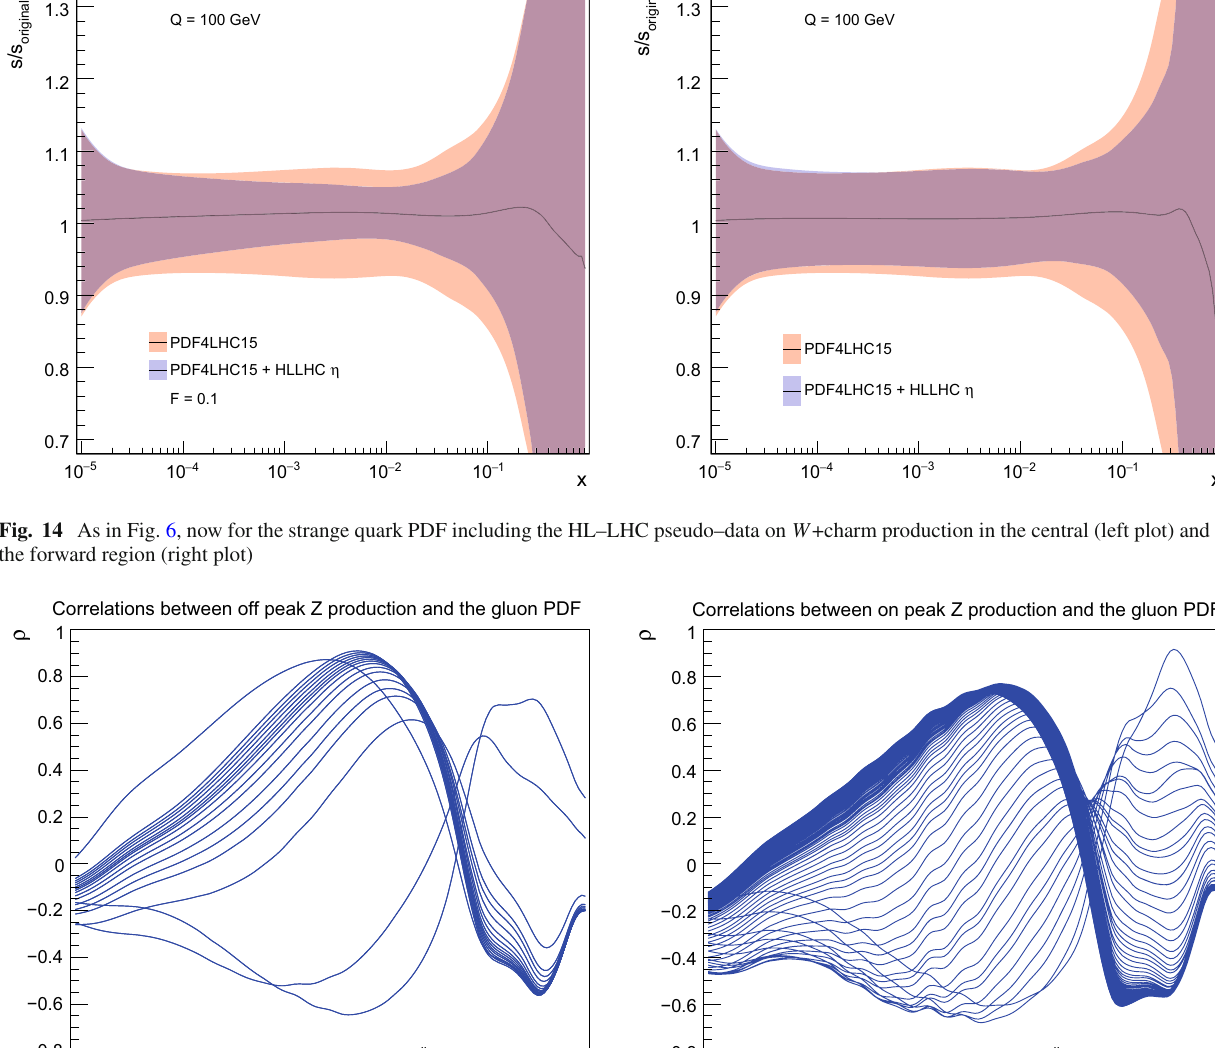
show the data vs. theory comparison only for the dominant dilepton invariant mass bin, 66 GeV ≤ m ll ≤ 116 GeV, although in the PDF profiling the effects of all the six m ll bins are being taken into account. To begin with, in Fig.